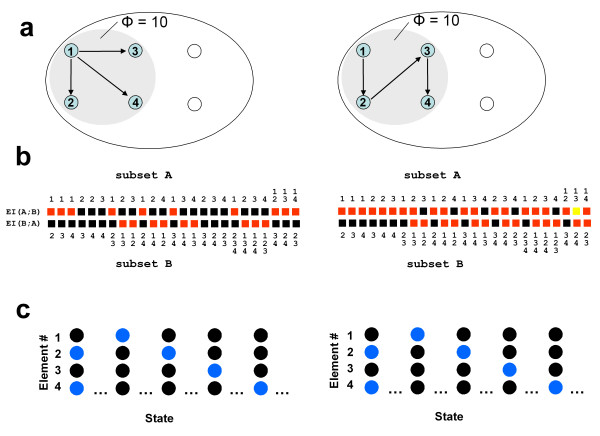
Effective information matrix and activity states for two complexes having the same value of Φ. a. Causal interactions diagram and analysis of complexes. Shown are two systems, one with a "divergent" architecture (left) and one with a "chain" architecture (right). The analysis of complexes shows that both contain a complex of four elements having a Φ value of 10. b. Effective information matrix. Shown is the effective information matrix for the two complexes above. For each complex, all bipartitions are indicated by listing one part (subset A) on the upper row and the complementary part (subset B) on the lower row. In between are the values of effective information from A to B and from B to A for each bipartition, color-coded as black (zero), red (intermediate value) and yellow (high value). Note that the effective information matrix is different for the two complexes, even though Φ is the same. The effective information matrix defines the set of informational relationships, or "qualia space" for each complex. Note that the effective information matrix refers exclusively to the informational relationships within the main complex (relationships with elements outside the main complex, represented here by empty circles, do not contribute to qualia space). c. State diagram. Shown are five representative states for the two complexes. Each is represented by the activity state of the four elements of each complex arranged in a column (blue: active elements; black: inactive ones). The five states can be thought of, for instance, as evolving in time due the intrinsic dynamics of the system or to inputs from the environment. Although the states are identical for the two complexes, their meaning is different because of the difference in the effective information matrix. The last four columns represent four special states, those corresponding to the activation of one element at a time. Such states, if achievable, would correspond most closely to the specific "quale" contributed by that particular element in that particular complex.